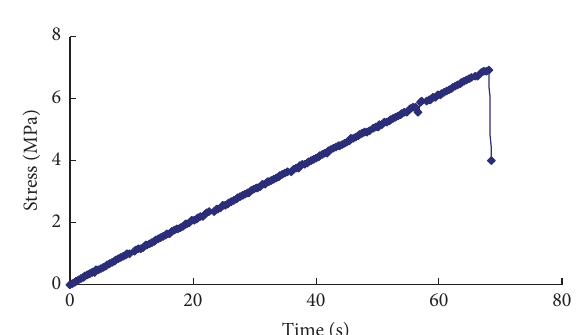
Figure 1: Diagram of loading directions.